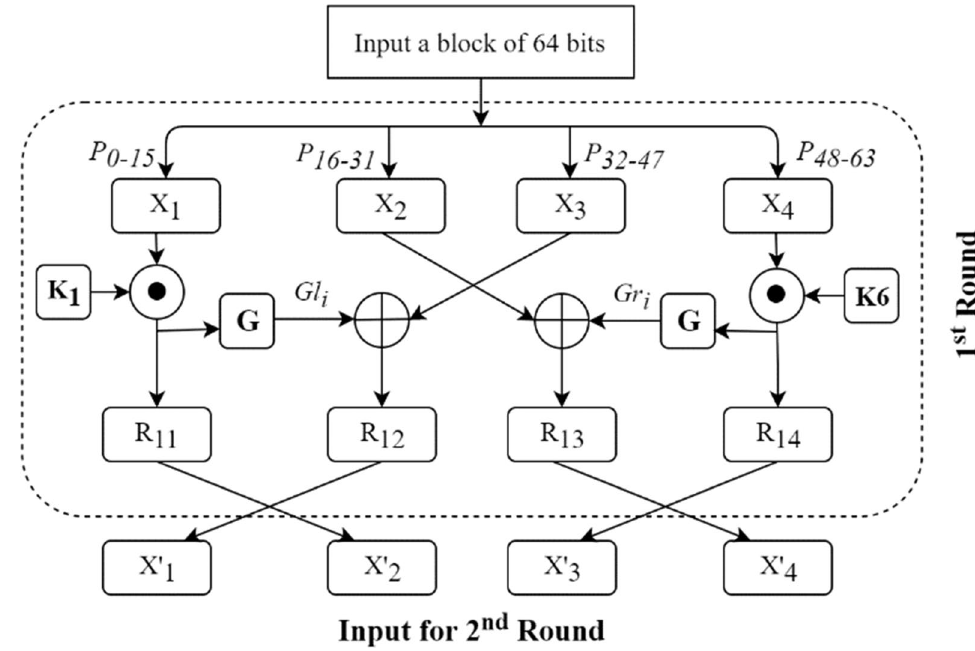
Fig. 6 The first round of encryption and input for 2nd round (RBFK-128